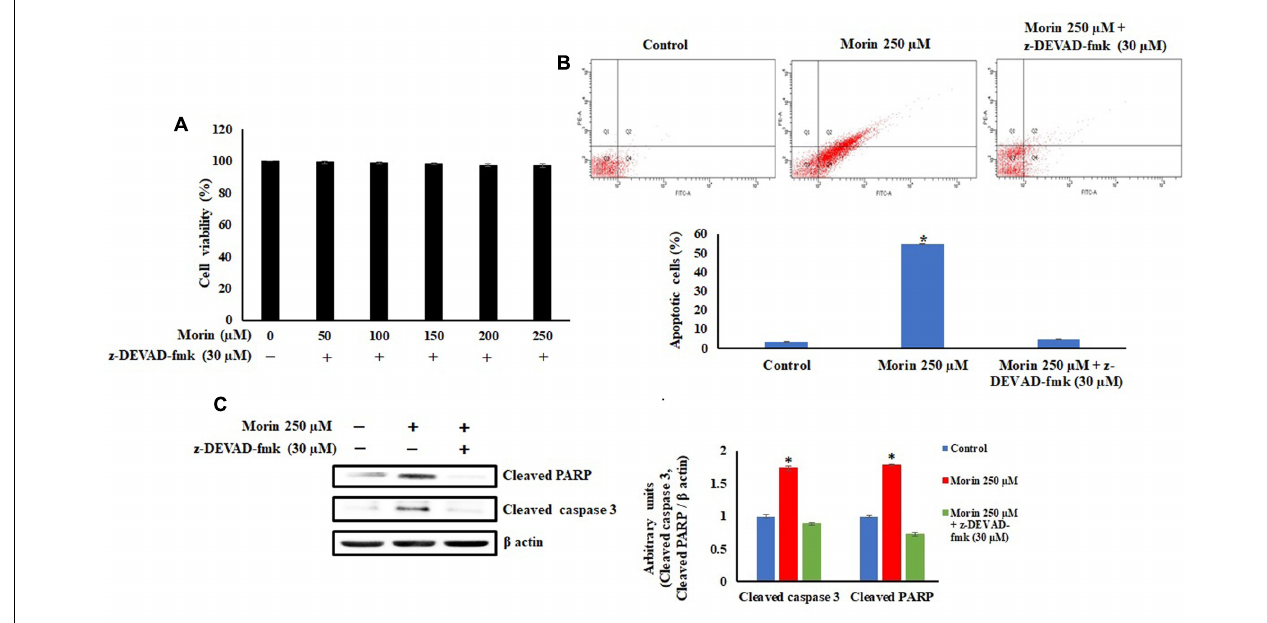
FIGURE 6 | Morin induces caspase 3 mediated apoptosis. SW480 cells were pretreated with the caspase 3 inhibitor, z-DEVAD-fmk (30 µ M), for 2 h prior to the addition of morin and cells were further incubated for 48 h. (A) Change in cell viability was assessed by MTT assay, (B) Apoptosis was measured using Annexin V-FITC/propidium iodide staining and flow cytometric analysis and (C) level of cleaved caspase 3 and cleaved PARP levels were examine by Western blotting. Each value represents mean ± SD (standard deviation) from three independent experiments. Significance levels between different groups were determined by using one way ANOVA, followed by Duncan’s multiple range test. ∗ p ≤ 0.05 versus